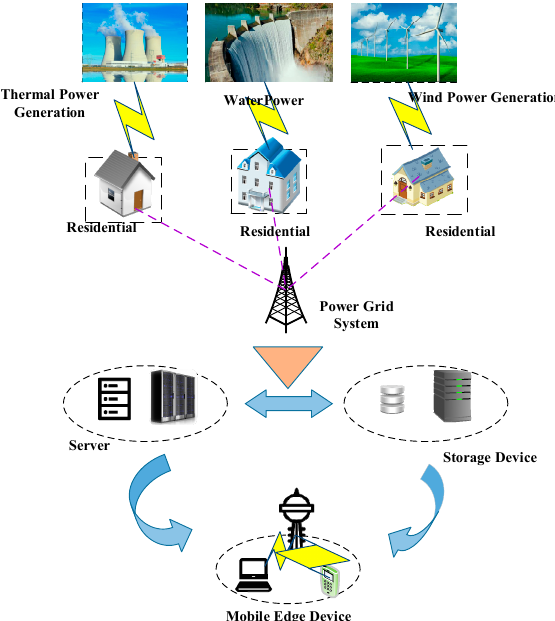
Figure 3. PGS communication model.